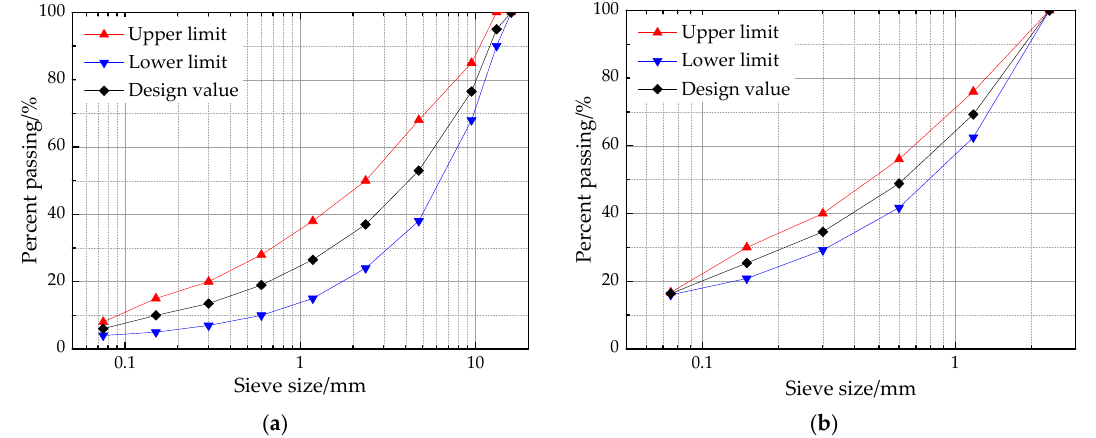
Figure 1. Gradations of asphalt mixes used in this study: ( a ) asphalt mixture; ( b ) asphalt mortar.